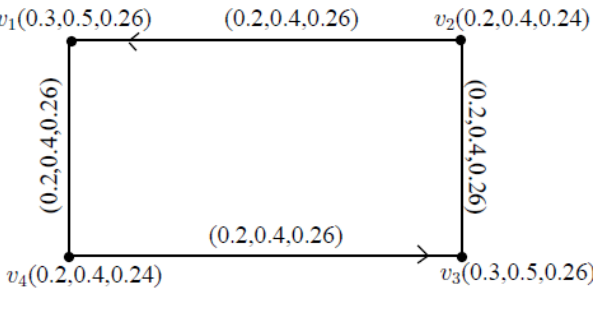
Figure 5: Regular Mixed Picture Fuzzy